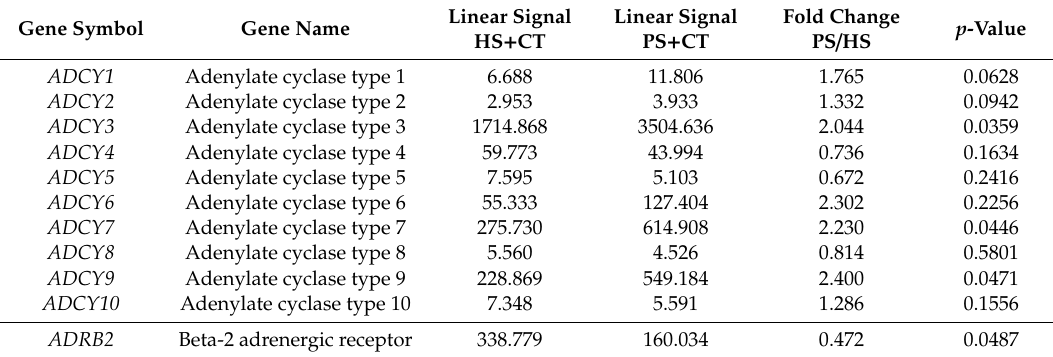
Table 1. Linear signals and fold change for ADCY1-10 and ADRB2 genes between healthy and psoriatic substitutes produced with CT.